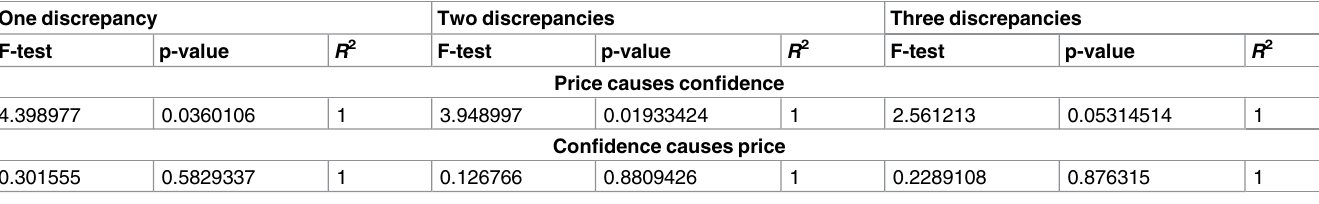
Table 5. Results of the Granger test for the causality relationship analysis. One